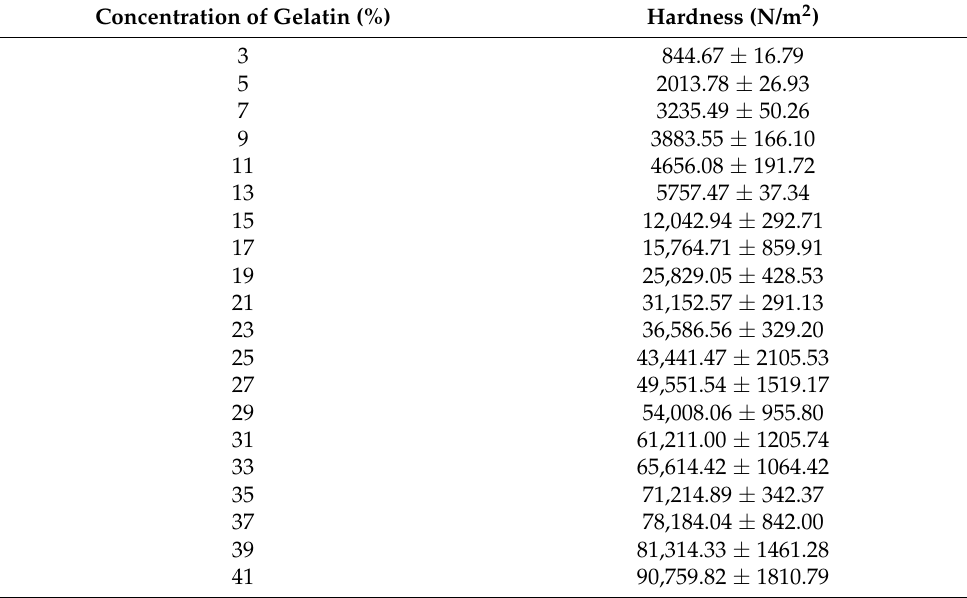
Table 5. Hardness of mousse type braised Sacha inchi added with gelatin